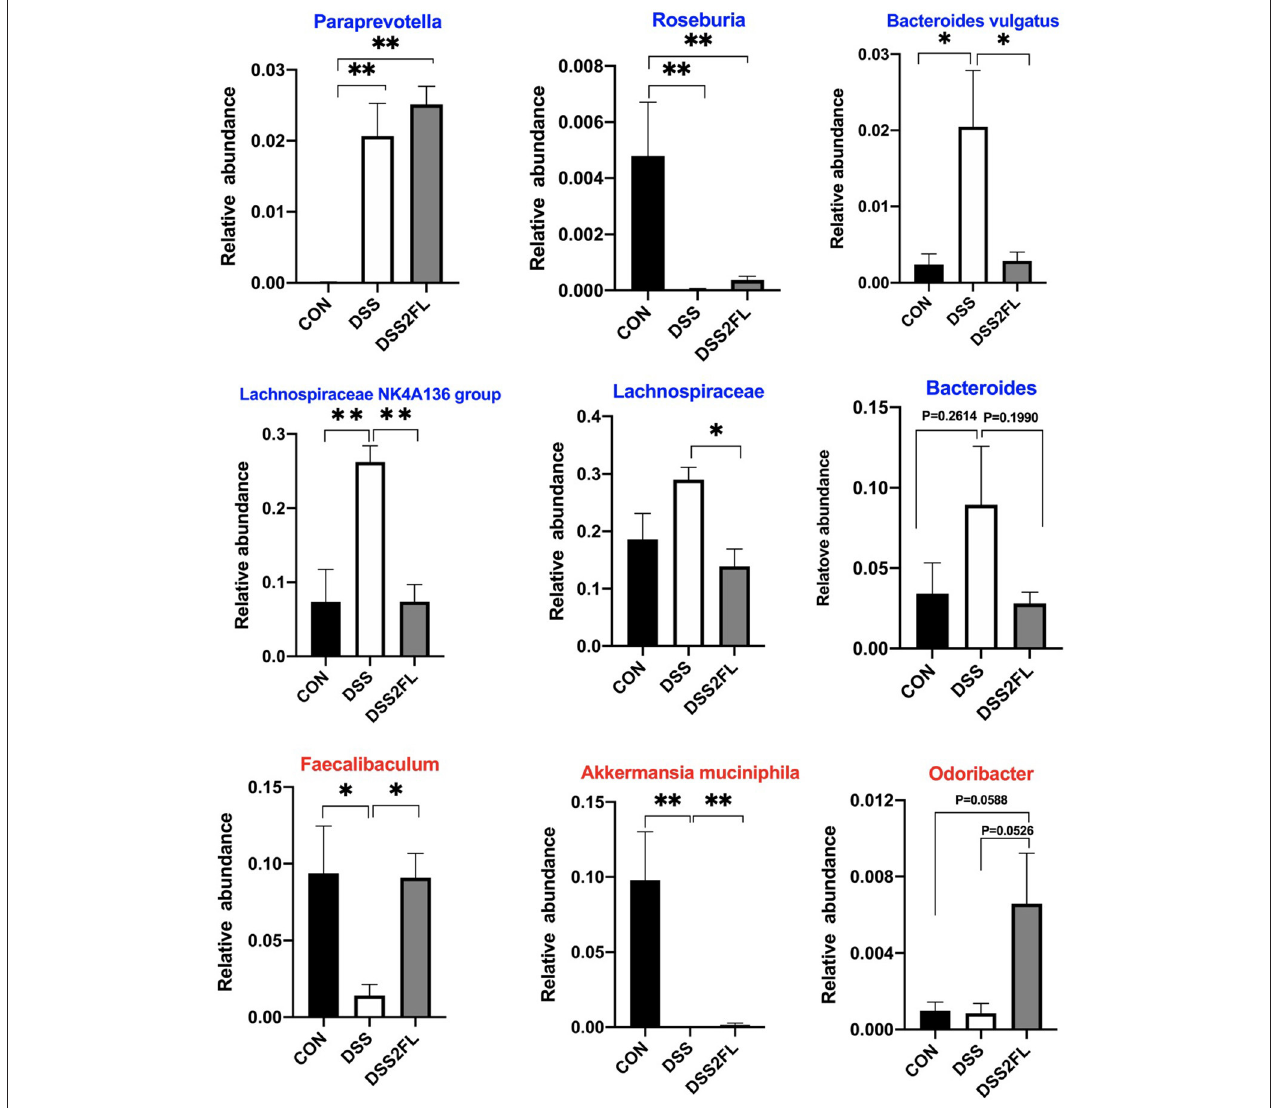
FIGURE 6 | 2 ′ -FL alters mucin-utilizing bacteria. Blue font, the bacterial genus encodes cleavage genes and transporters of mucin-associated O-glycans; red font, the bacterial genus encodes cleavage genes of mucin-associated O-glycans. Significance was determined using one-way ANOVA analysis and expressed as mean ± SEM. * p < 0.05; ** p <